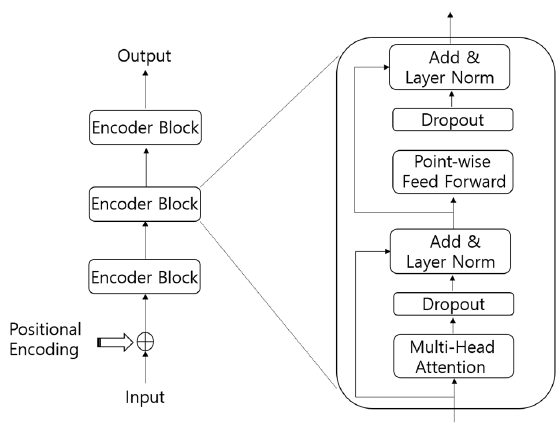
Figure 1. Structure of the Transformer encoder .